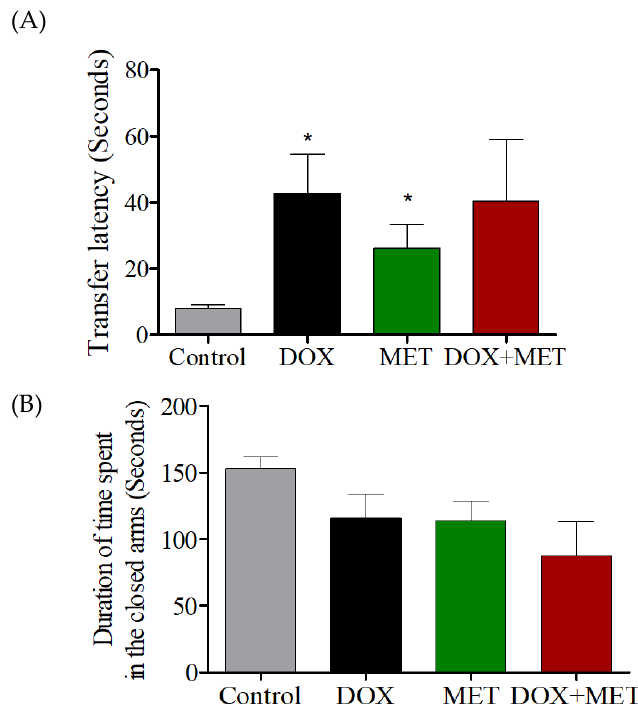
Figure 4. ( A ) Effects of DOX and MET on the transfer latency time in the elevated plus maze test. ( B ) Effects of DOX and MET on the total time spent in the closed arms in the elevated plus maze test.